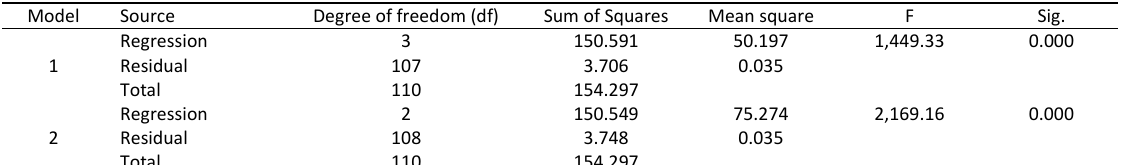
Table 3: Analysis of variance of the proposed models